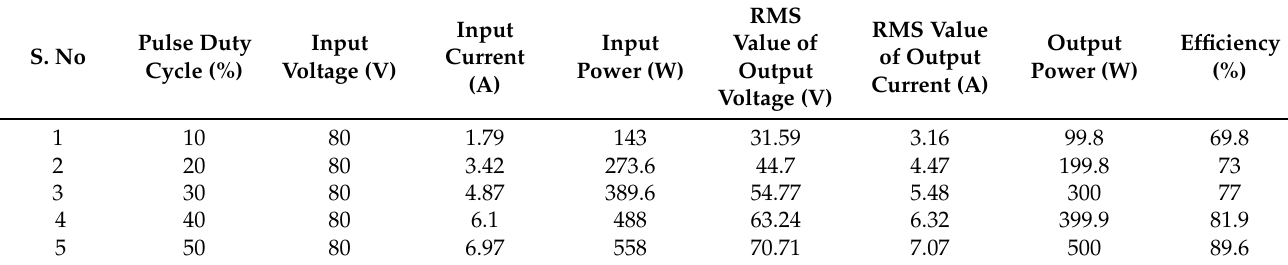
Figure 7. Pulse duty cycle control with 30 kHz frequency. ( a ) Switching pulses for 50% pulse duty cycle. ( b ) Output voltage and current waveforms for 50% pulse duty cycle. ( c ) Output voltage and current waveforms for 10% pulse duty cycle. ( d ) Switch voltage and current waveforms. ( e ) Tempera- ture variation. ( f ) Heat rate for various pulse duty cycles. ( g ) FLIR thermal image for various pulse duty cycles at t = 5 min. Table 2. Efficiency of pulse duty cycle